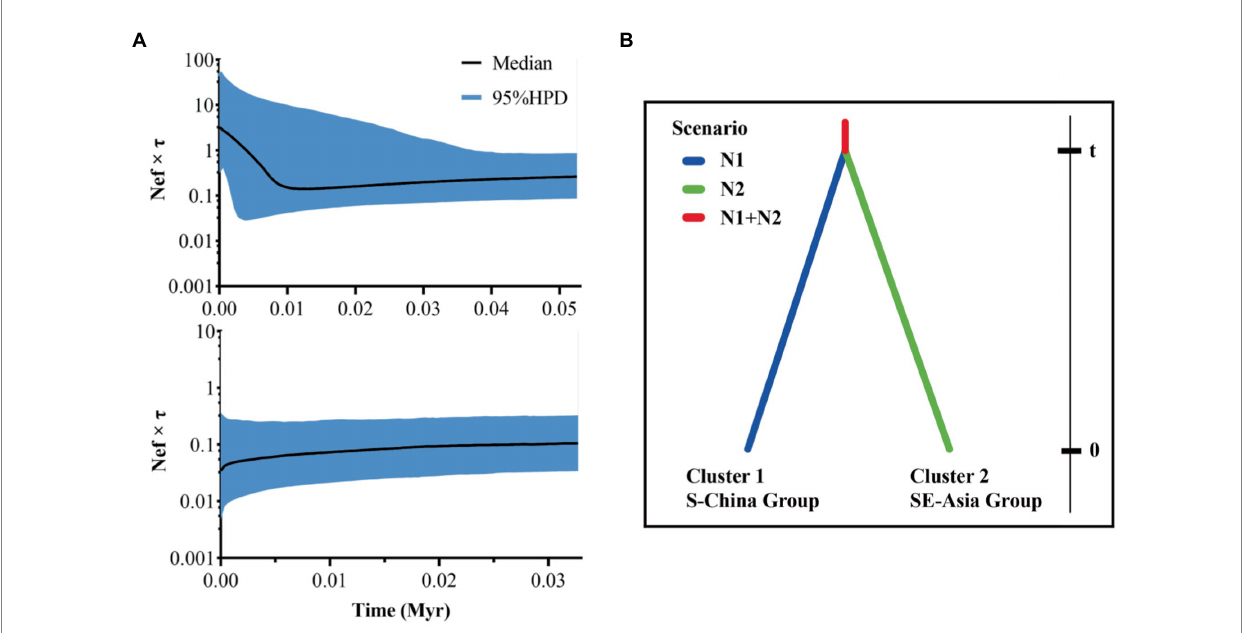
FIGURE 2 Bayesian skyline plots (A) and divergent models (B) based on existing assumptions. For Bayesian skyline plots (A) , above is about the S-China Group, and below is about the SE-Asia Group; middle lines represent median estimates of the effective population size (Nef) multiplied by the generation time ( τ ) in years, and shaded areas represent 95% highest posterior densities (95% HPD); Nef × τ is presented on a logarithmic scale. For divergent models (B) , t is divergence time of N 1 and N 2; N 1 and N 2 are effective population sizes of clusters 1–2 of C. kiangsu , respectively.